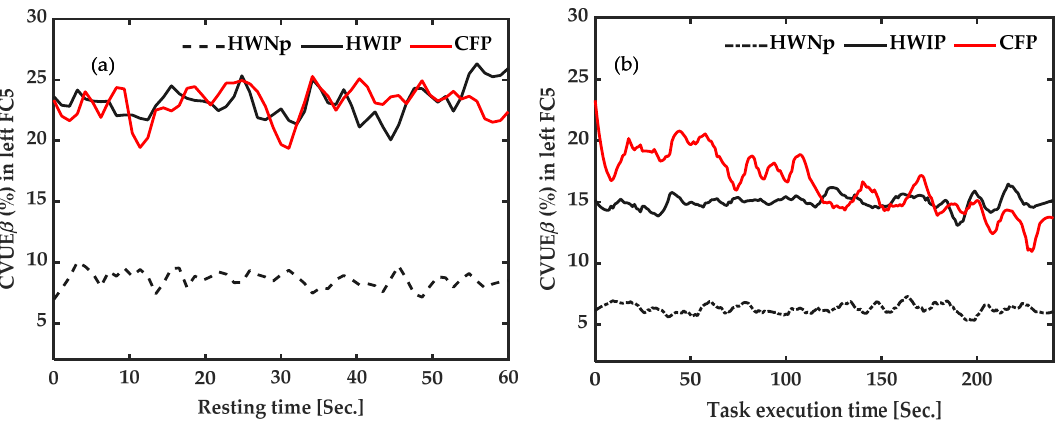
Figure 7. Baseline and active measures of the coefficient of variation of upper envelope (CVUE) in beta (CVUE β ) from FC5 in the three groups. The black dotted line indicates the average of CVUE β of healthy subjects with “No pain” (HWNp). The average of CVUE β in (1) the seven participants with induced pain (HWIP) (black line) and (2) the four chronic pain (CFP) subjects (red line), at rest ( a ) and during task ( b ). CVUE β from FC5 was significantly higher in participants both with chronic pain and experimental pain in comparison to healthy participants with “No pain”, at rest.